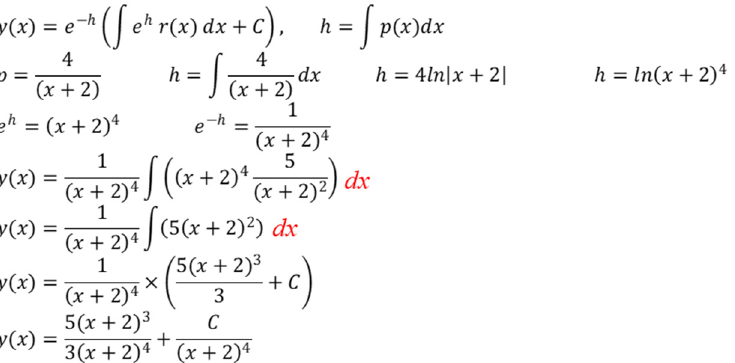
Figure 2. Reproduced example of correct solution to Example 2 using Formula (13).